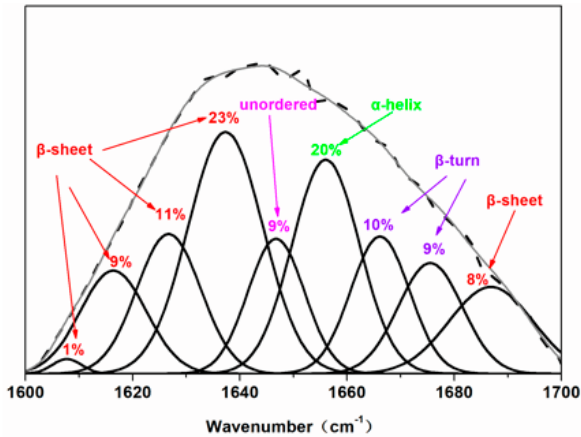
Figure 6. Deconvolution of the amide I spectra (continuous curve), the Gaussian curve fit (GCF) bands thereof (point line), and the second-derivative spectra of the TDS-sodium dodecyl sulfate (SDS) sample.